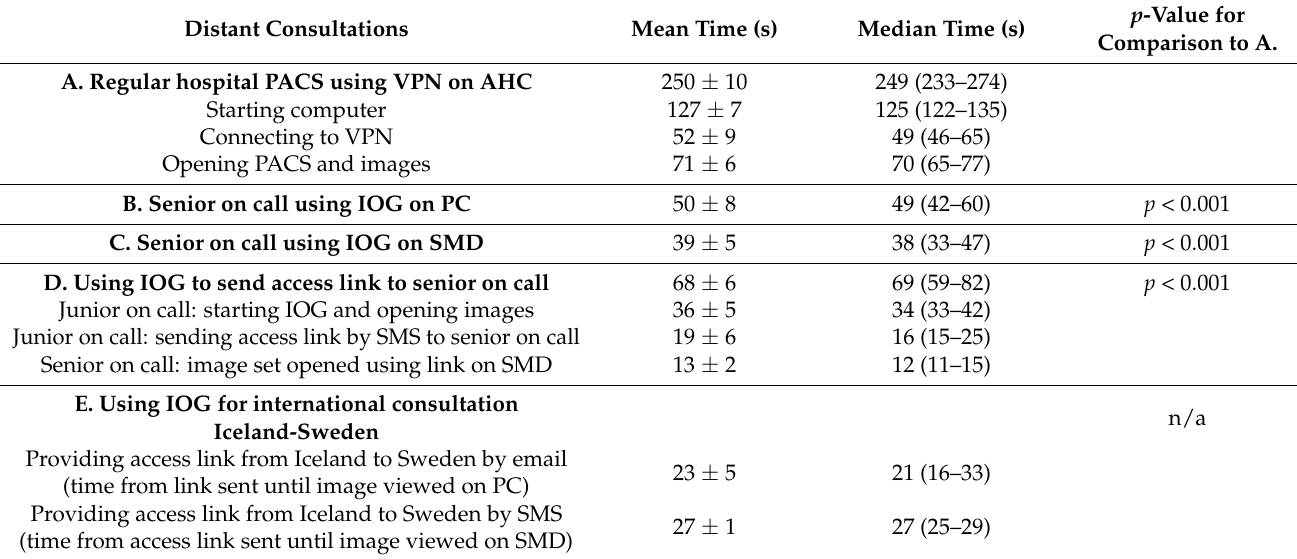
Table 3. Consultation times using IOG for distant access to clinical